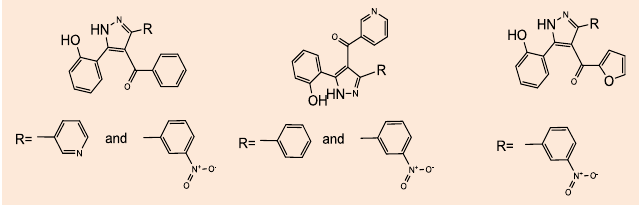
Figure 2. Structures of pyrazoles used in present